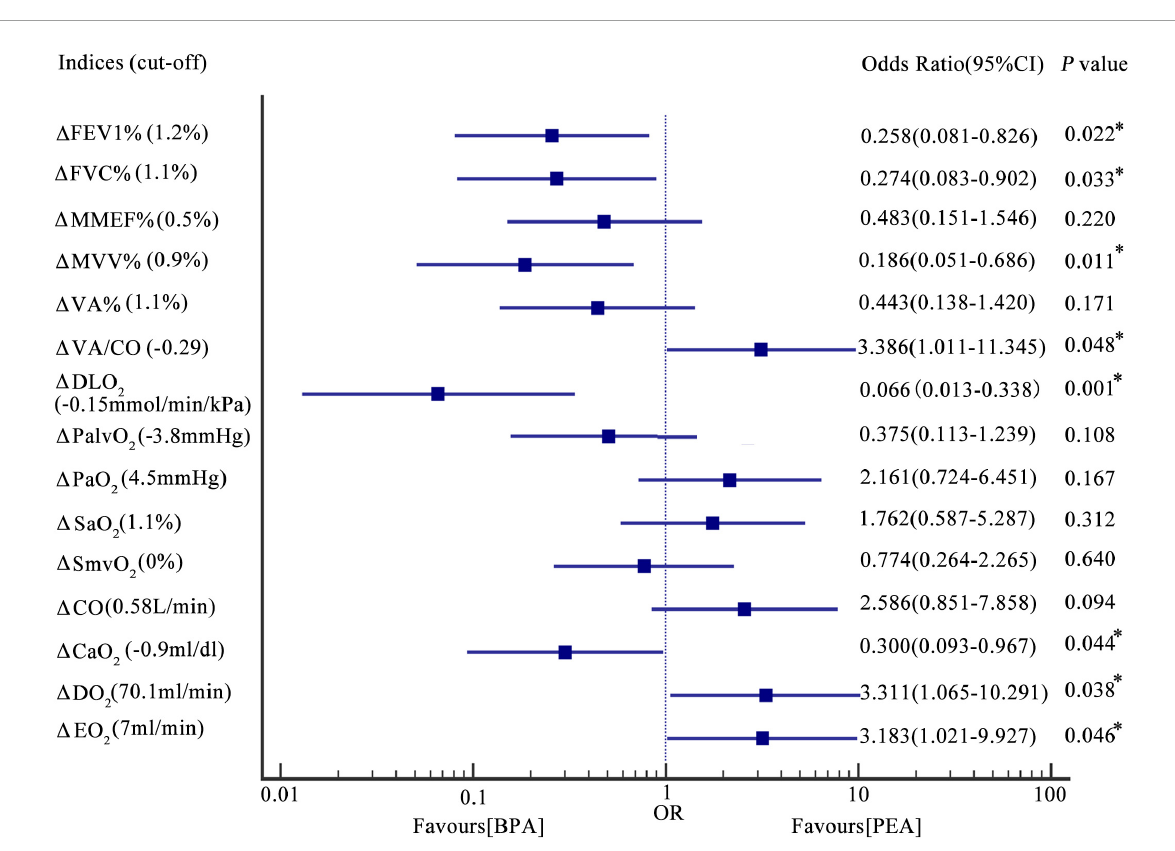
FIGURE3 Forest plot-the association between the change in oxygen pathway indices and the interventional method. Results were based on logic regression analysis (see also the statistical analysis section). The incidences of change in FEV1% > 1.2%, FVC% > 1.1%, MVV% > 1.1%, VA/CO < –0.29, DLO 2 > –0.15 mmol/min/kPa, CaO 2 > –0.9 ml/dl, DO 2 > 70.1 ml/min, and EO 2 > 7 ml/min in patients post-PEA were 0.258, 0.274, 0.186, 3.386, 0.066, 0.300, 3.311, 3.183 times as those in patients post-BPA. Incidences of change in MMEF% > 0.5%, VA% > 1.1%, PalvO 2 < –3.8 mmHg, PaO 2 > 4.5 mmHg, SaO 2 > 1.1%, SmvO 2 > 0%, and CO > 0.58 L/min were comparable between patients post-PEA and BPA. ∗ P < 0.05. (cid:49) , change in the indices. PEA, pulmonary endarterectomy; BPA, balloon pulmonary angioplasty; FEV1%, the percentage of the forced expiratory volume in the 1 s; FVC%, the percentage of the forced vital capacity; MMEF%, the percentage of the predicted maximum mid-expiratory flow; MVV%, the percentage of the predicted maximum voluntary ventilation; VA%, the percentage of the predicted alveolar ventilation; VA/CO, alveolar ventilation-to-cardiac output ratio; DLO 2 , diffusion capacity of the lungs for oxygen; PaO 2 , partial pressure of oxygen in the radial artery; PalvO 2 , alveolar partial pressure of oxygen; SaO 2 , saturation of oxygen in the radial artery; SmvO 2 , mixed venous oxygen saturation; CO, cardiac output; CaO 2 , arterial oxygen content; DO 2 , oxygen delivery; EO 2 , oxygen